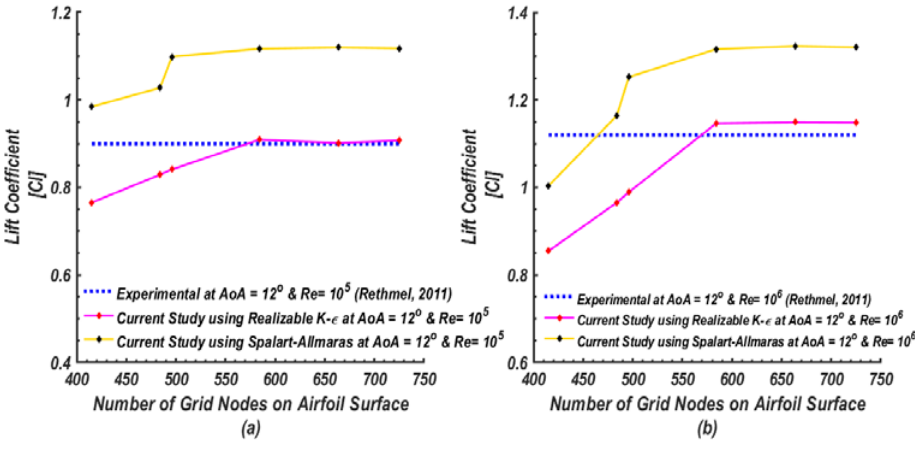
Figure 2. Results of mesh intensity inspection for lift coefficient as predicted by the Spalart-Allmaras and the Realizable k- ε models at AoA = 12° for ( a ) Re = 10 5 and ( b ) Re =10 6 .